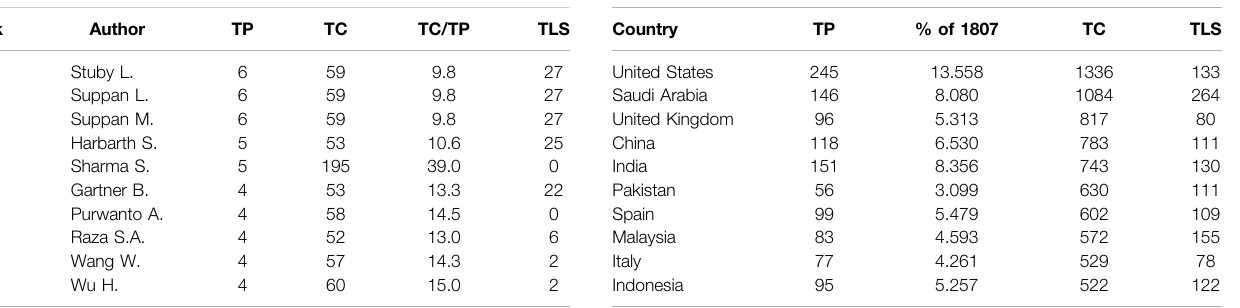
TABLE 2 | Top 10 most impactful authors in this fi eld.